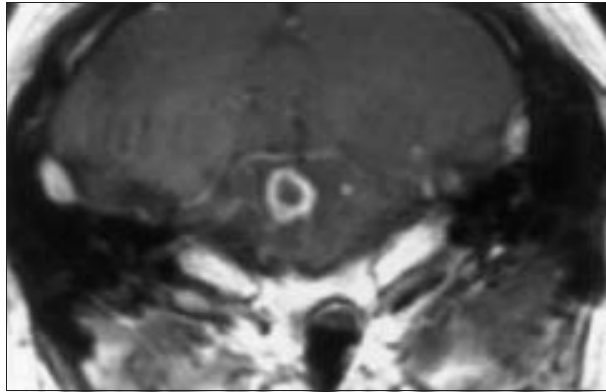
Figure 1) Ring enhancing lesion (6 mm) at the level of the pons in magnetic resonance image performed on day